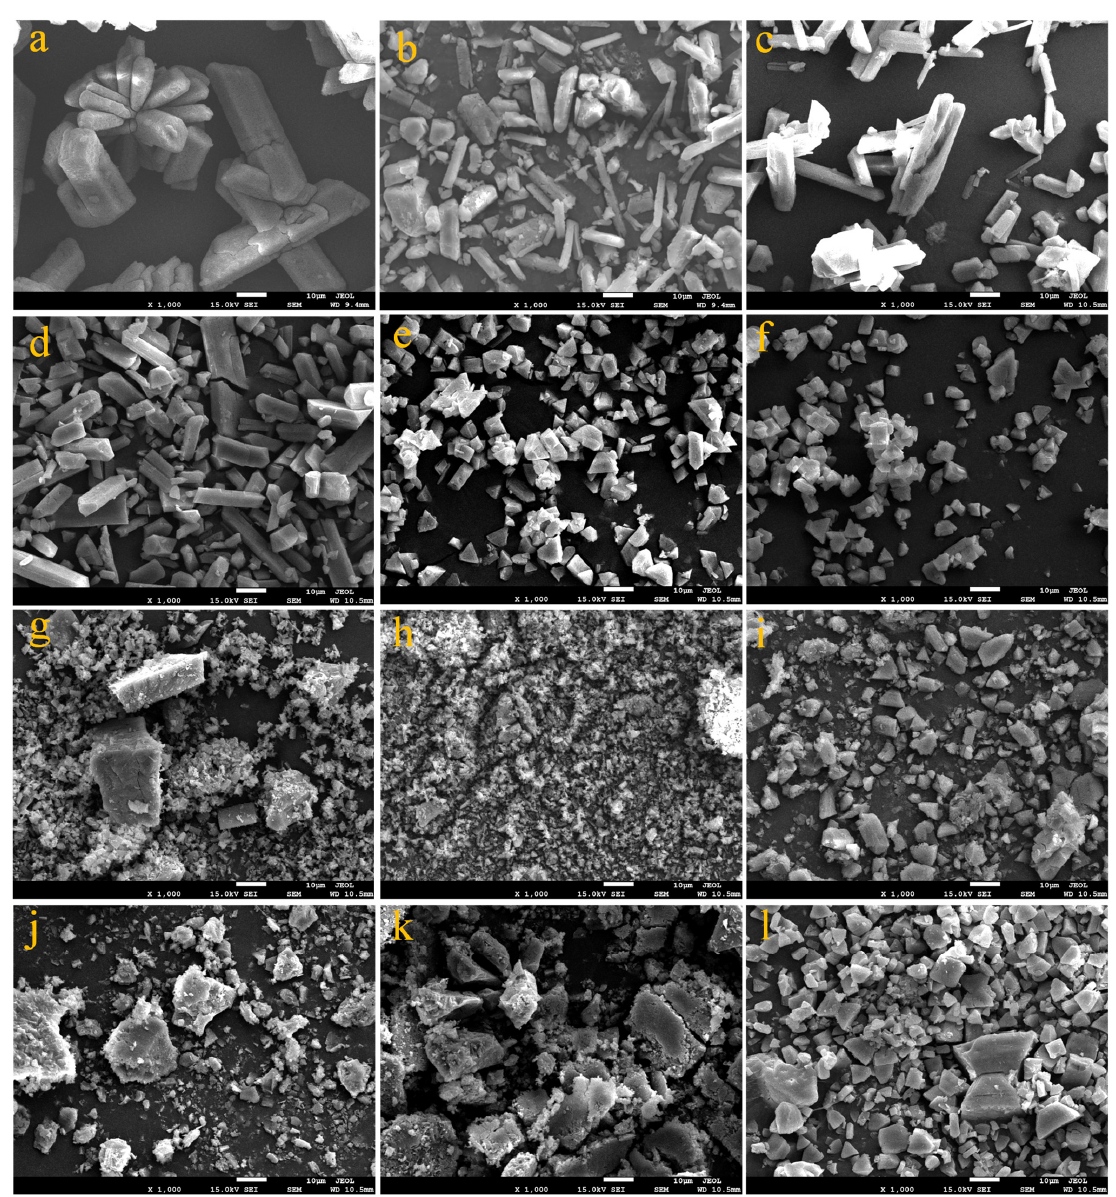
Figure 10. SEM images of precipitates for ( a ) analytical grade struvite (98%); ( b ) control; at different concentrations: ( c ) 200 mg/L BSA, ( d ) 500 mg/L BSA, ( e ) 200 mg/L SA, ( f ) 500 mg/L SA, ( g ) 200 mg/L HA, ( h ) 500 mg/L HA; at different combinations: ( i ) 500 mg/L BSA + 500 mg/L SA, ( j ) 500 mg/L BSA + 1500 mg/L HA, ( k ) 500 mg/L SA + 1500 mg/L HA, ( l ) 100 mg/L BSA + 100 mg/L SA + 200 mg/L HA.